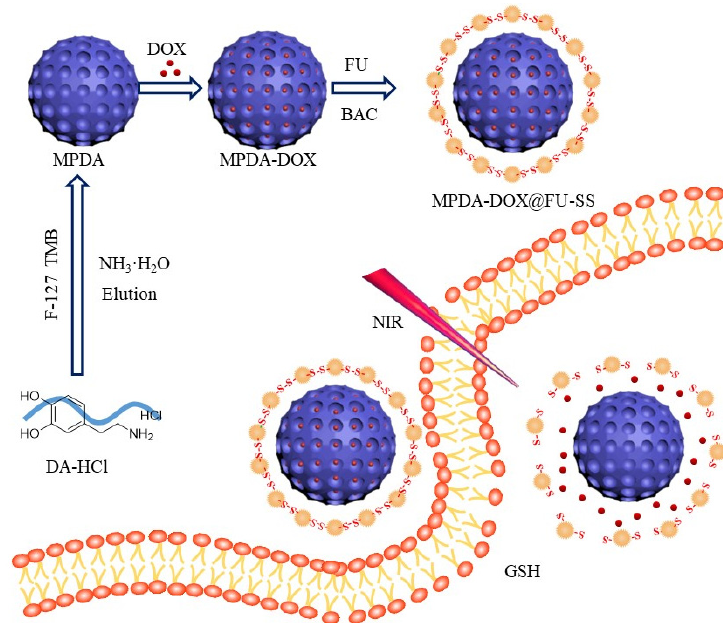
Figure 10. Schematic diagram of the preparation and release of MPDA-DOX@FU-SS nanoparticles.